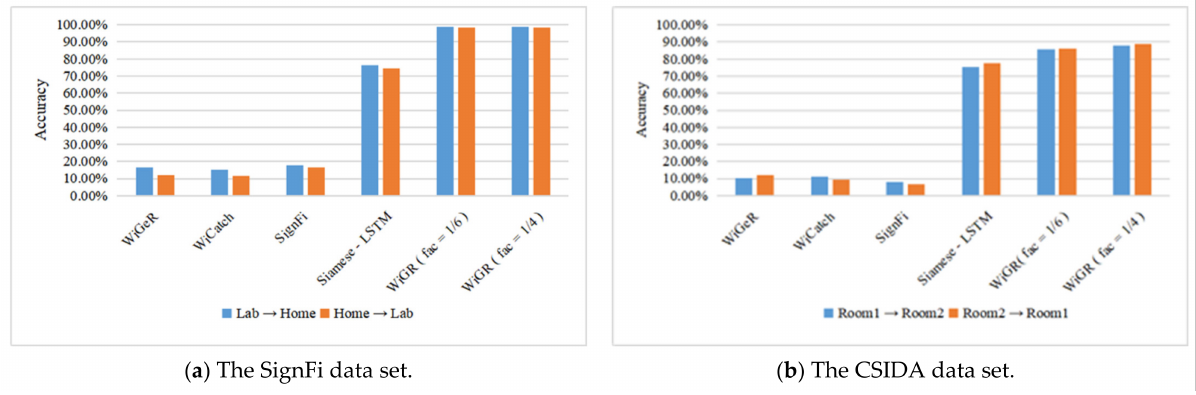
Figure 7. Accuracy of cross-environment evaluation.